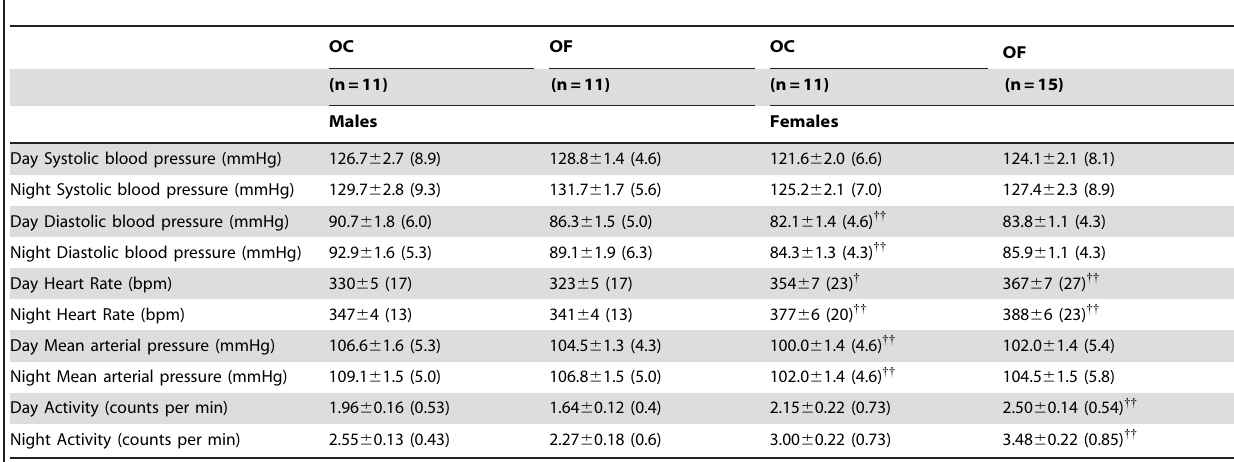
Table 2. Basal cardiovascular parameters and activity in adult offspring born to dams fed a control (OC) or a fat diet (OF).